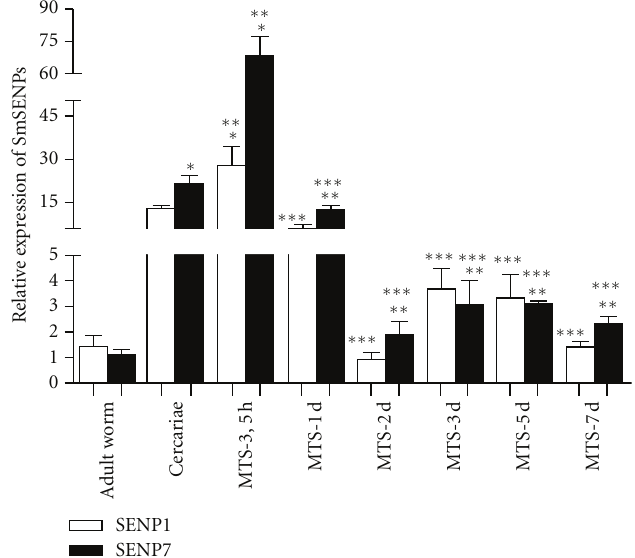
Figure 3: Sm SENPs are di ff erentially expressed throughout the S. mansoni life cycle. The mRNA expression levels were measured based on three replicates, for each of the following stages: adult worms, cercariae, MTS-3.5h, 1, 2, 3, 5, and 7 days using quantitative RT- PCR. Expression levels were calibrated according to the comparative 2 − Δ C t method, using the constitutively expressed Sm α -tubulin as an endogenous control (one-way variance analysis followed by Tukey pairwise comparison P < 0.05). ∗ Di ff erent from adult worm, ∗∗ di ff erent from cercariae, and ∗∗∗ di ff erent from MTS-3.5h.